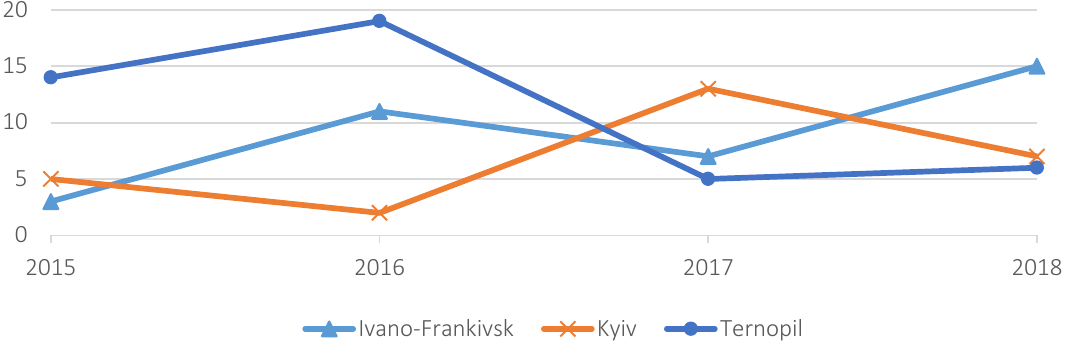
Figure 1. Ranking positions of Ivano-Frankivsk, Kyiv and Ternopil regions in the rating of